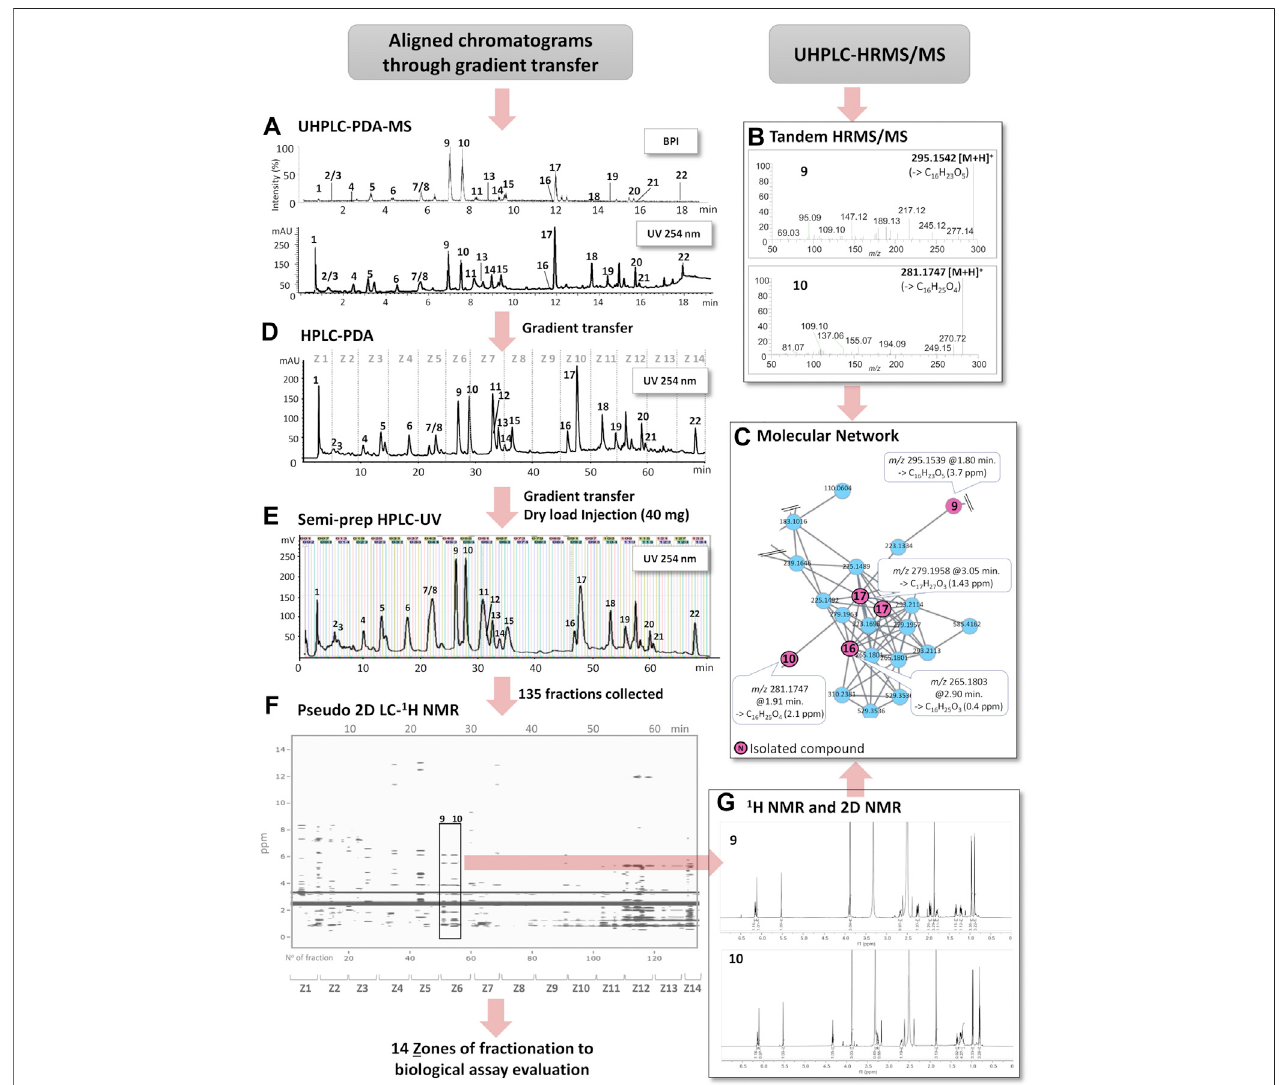
FIGURE1| Schematicoverviewofthework fl owofthisstudy. (A) OptimizedUHPLC-DAD-MSpro fi leoftheethylacetatecrudeextract(basepeakintensity(BPI),PI mode) and UV trace (254 nm). (B) HRMS/MS spectra of the LC peaks from the UHPLC-HRMS/MS extract pro fi le corresponding to the isolated compounds 9 and 10 . (C) Selected part of an MN cluster highlighting the features of 9 , 10 , 16 , and 17 (series of structurally related pyrone derivatives). Some of the other features were dereplicated based on MN annotation propagation (see Table 2 ). (D) HPLC-DAD chromatogram after gradient transfer from (A) . Z1 to Z14 indicate chromatographic zones combined in semi-preparative HPLC for the bioassay monitoring, shown on (D) for a clearer display. (E) Semi-preparative HPLC-UV chromatogram after gradient transfer from (D) and dryload sample introduction; vertical lines represent collected fractions. (F) Pseudo-LC-NMR obtained by a combinationofthe 1 H-NMRspectraofallfractionsfrom (E) intoasinglematrix(ppmvs.R t orfractionN o ). (G) 1 H-NMRspectraoffractionsF51andF55highlightedinthe 2D plot (F) .